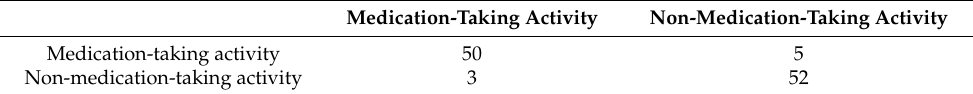
Table 3. Confusion matrix regarding medication film